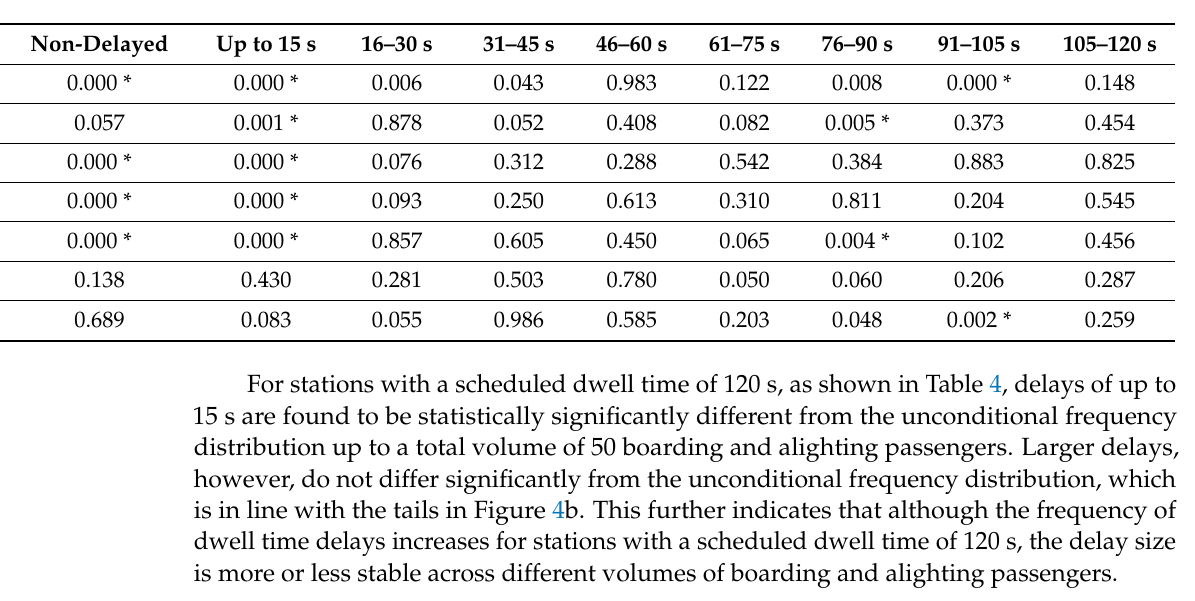
Table 4. Pairwise comparison for stations with a scheduled dwell time of 120 s. Significant results